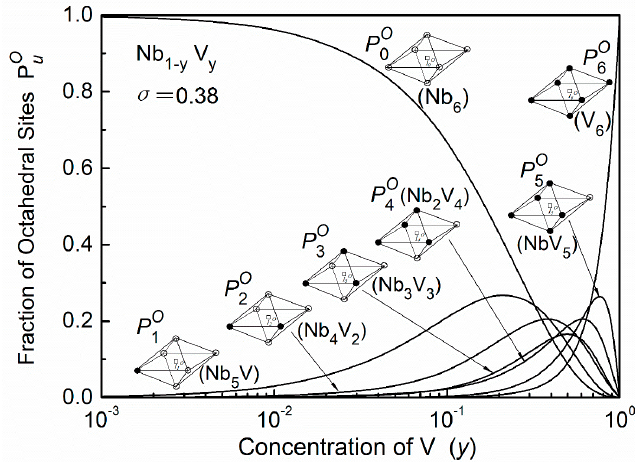
Figure 3. Fracion P uO of octahedral sites of a short range ordered Nb–V system ( σ = 0.38). The sites are distinguished by the different chemical composition in the first shell of neighbors. ( ○ —Nb atoms, ● —V atoms).